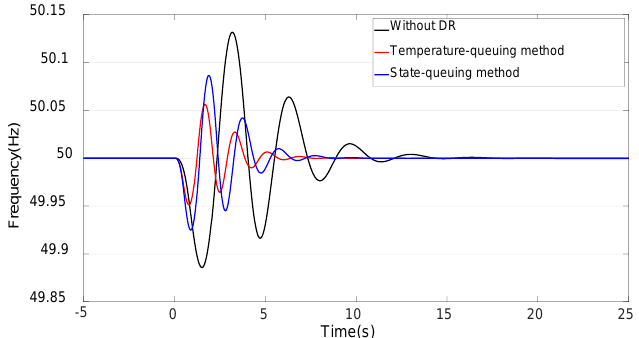
Figure 15. Frequency of microgrid under different control methods. Table 6. Parameter statistics under different control methods.